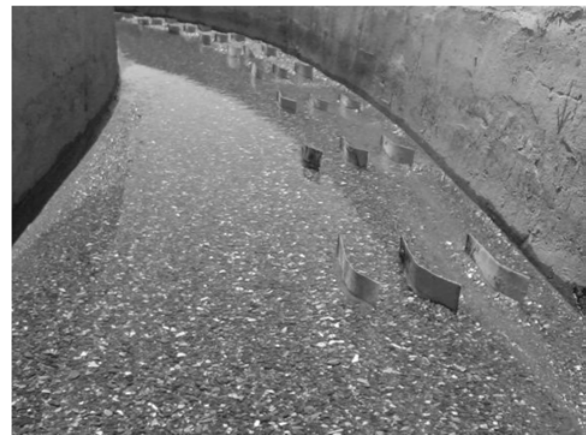
Fig. 4. Plan view of curved-vanes installation on the bed of model with 3-vanes in a row at parallel patterns